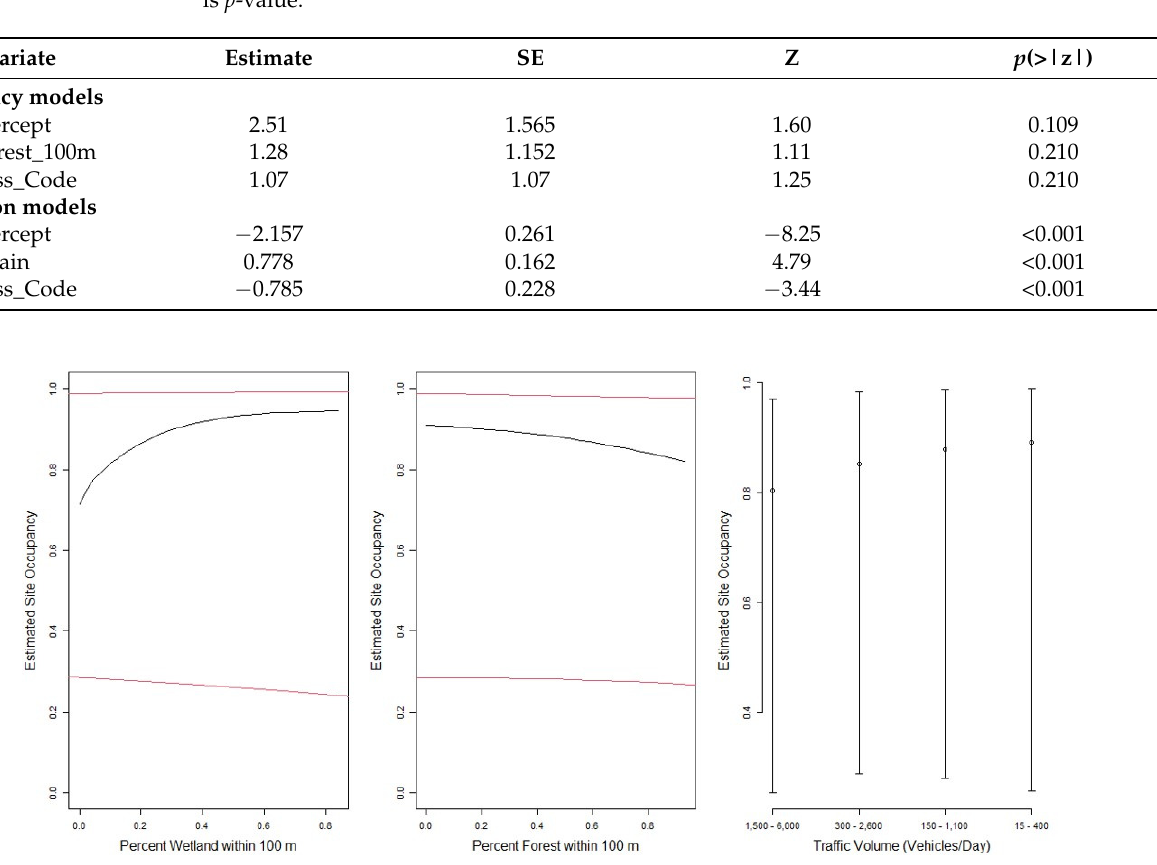
Figure 2. Marginal effect of covariates on estimated detection probability from the model-averaged results. Black lines represent model estimates for detection probability, and red lines represent up- per and lower confidence intervals. Plots hold other covariates at their mean value.